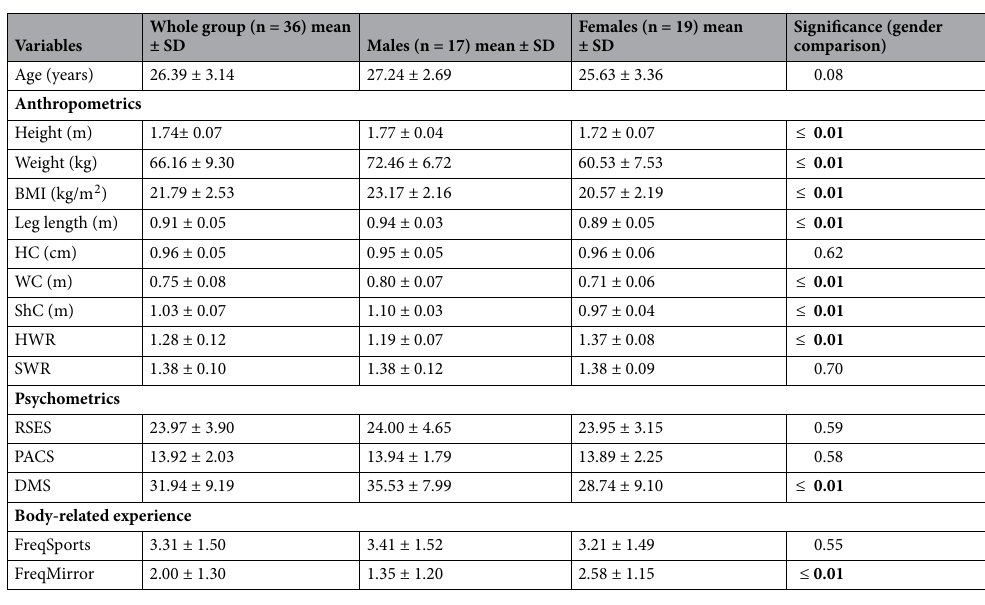
Table 1. Subject characteristics and group comparisons (t-tests and Mann–Whitney-U tests) for age, anthropometrics, psychometrics, and body-related experiences. HC hip circumference, WC